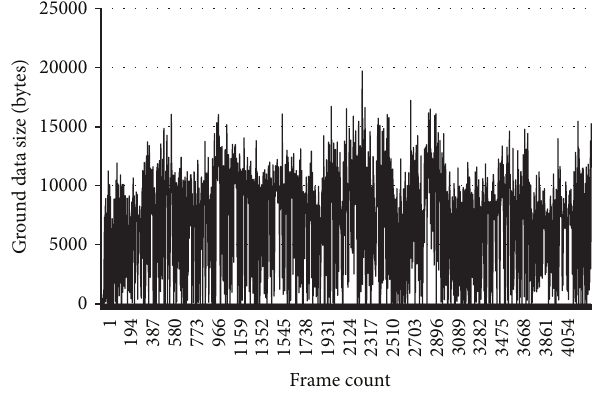
Figure 7: Ground data size after segmentation. Table 1: Stats of elapsed time by frame.